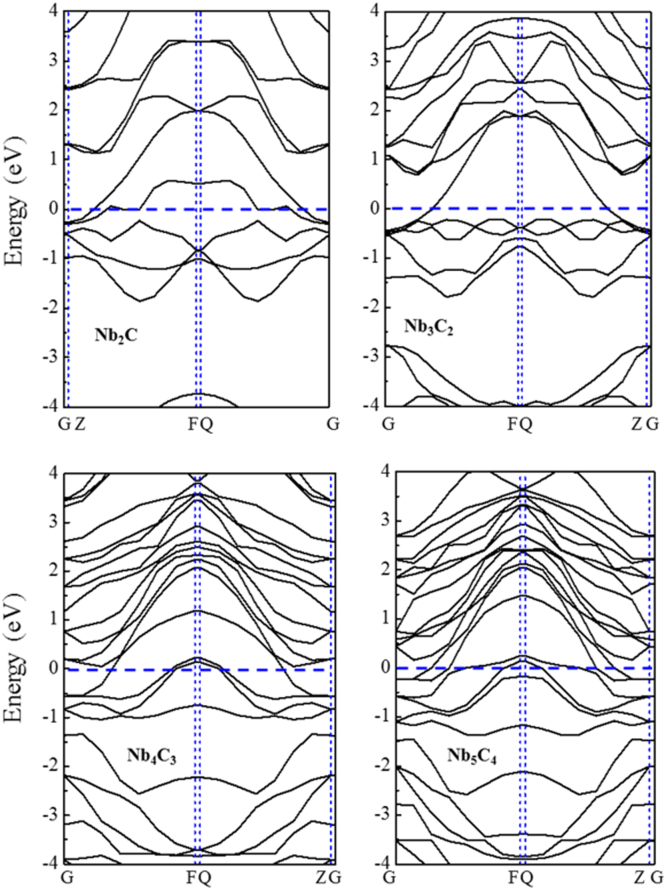
Band structures of the bare Nbn+1Cn (n = 1, 2, 3, 4).